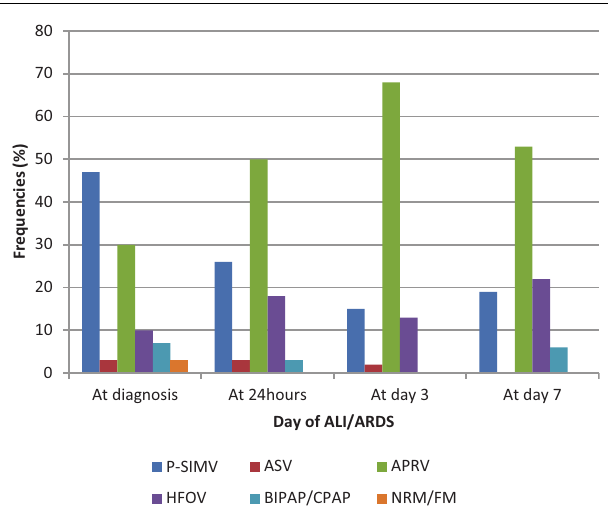
FIGURE 1 | Relative frequencies of modes of ventilation during the first week ofALI/ARDS are shown . P-SIMV: pressure-synchronized intermittent mandatory ventilation. ASV: adaptive support ventilation, APRV: airway pressure release ventilation. HFOV: high-frequency oscillatory ventilation. BIPAP: bi-level positive airway pressure. CPAP: continuous positive airway pressure. NRM: non-rebreather mask oxygen. FM: face mask oxygen.